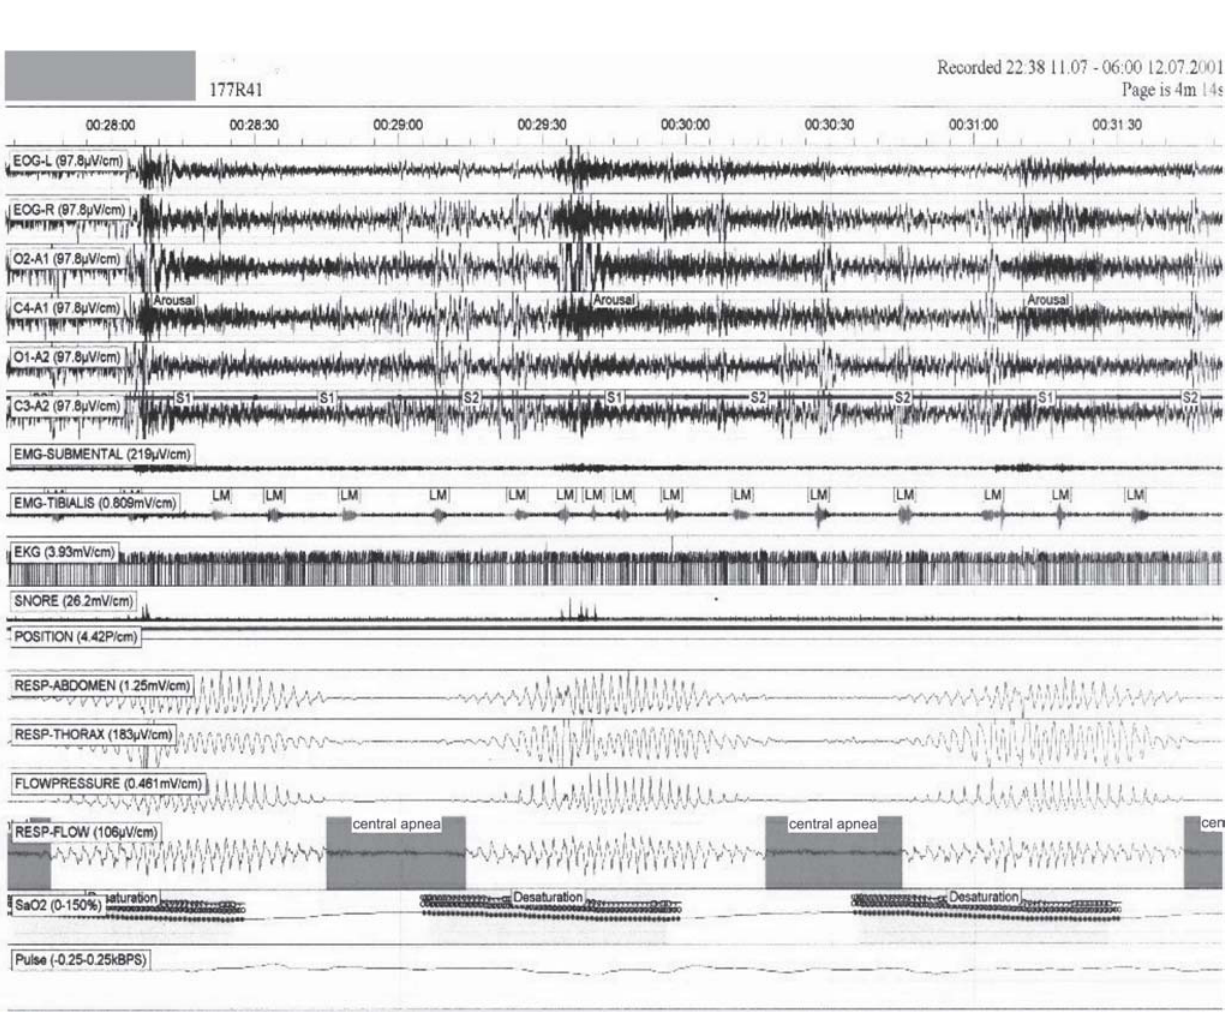
Figure 1 - Polysomnographic recordings of a congestive heart failure presenting Cheyne-Stokes respiration during sleep. The top channels are related to sleep recordings. The bottom channels trac respiration by monitoring motion of the thorax, abdomen and respiratory flow (nasal canula). Observe the typical crescendo-decrescendo tidal volume interposed with central